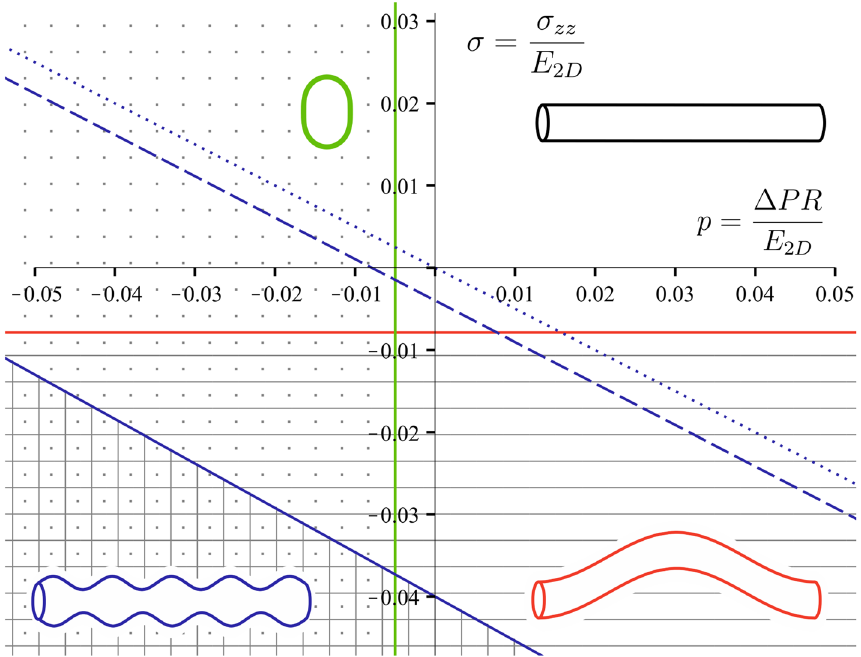
Figure 2. Stability domain of the tube with radius to length ratio R / L in the non-shaded area. The red line corresponds to the critical values of the axial stress σ zz leading to the Euler buckling instability. The green vertical line corresponds to the critical value of the pressure leading to the transversal buckling with wave numbers | n| = 2, m = 0 of the tube with bending rigidity γ blue lines corresponds to the critical values of the stress σ zz leading to the corrugation instability of tubes with various normalized bending rigidities: solid line γ σ σ zz / E 2 D , and the normalized bending rigidity γ =